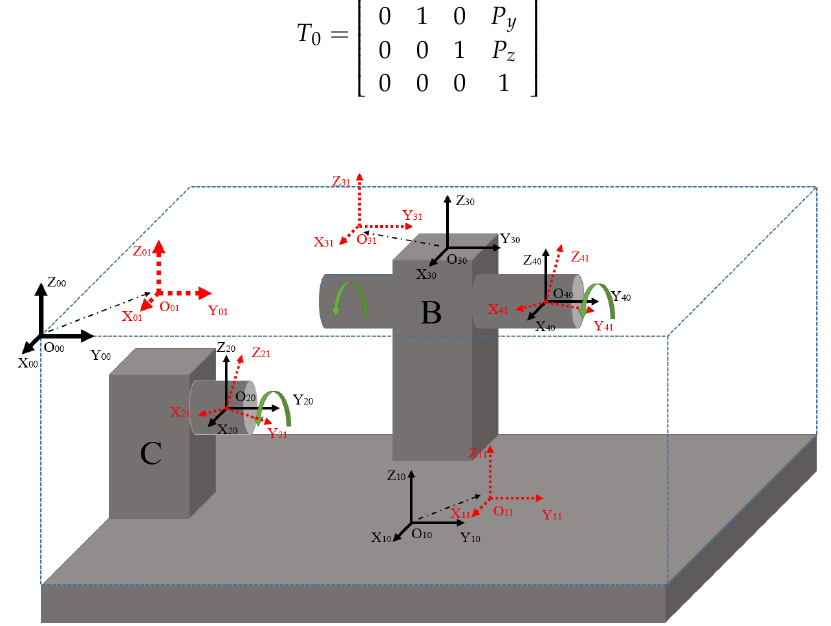
Figure 2. Exploded view of grinding machine motion coordinate system.